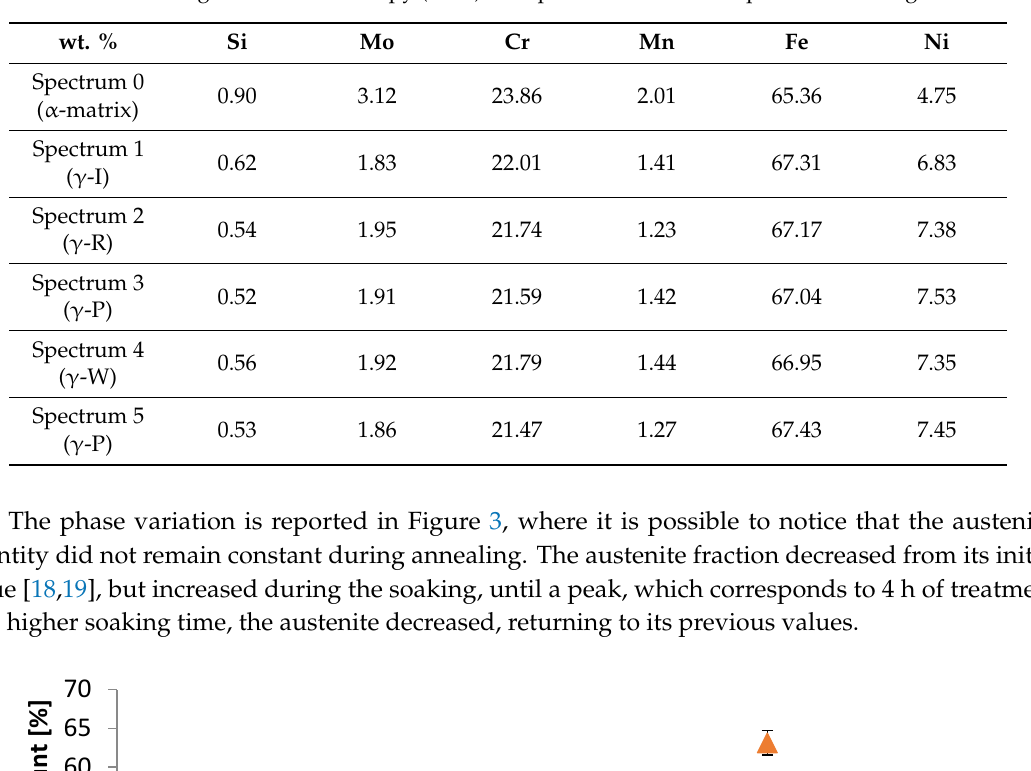
Table 3. Scanning electron microscopy (SEM)-EDS phases chemical composition from Figure 2c.